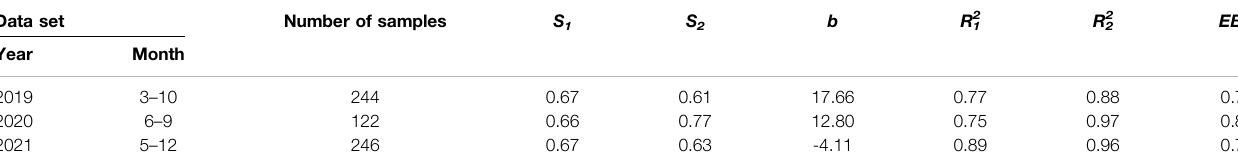
TABLE 6 | Characteristics of energy closure of the Inner Mongolian desert ecosystem at the daily scale. Data